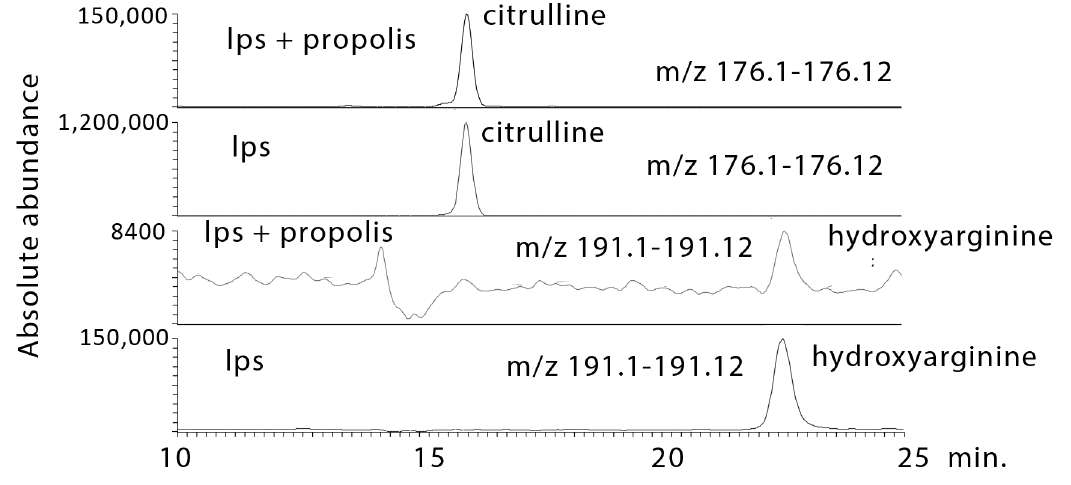
Figure 7. Extracted ion traces showing decreases in hydroxy arginine and citrulline in LPS-stimulated macrophages treated with propolis.